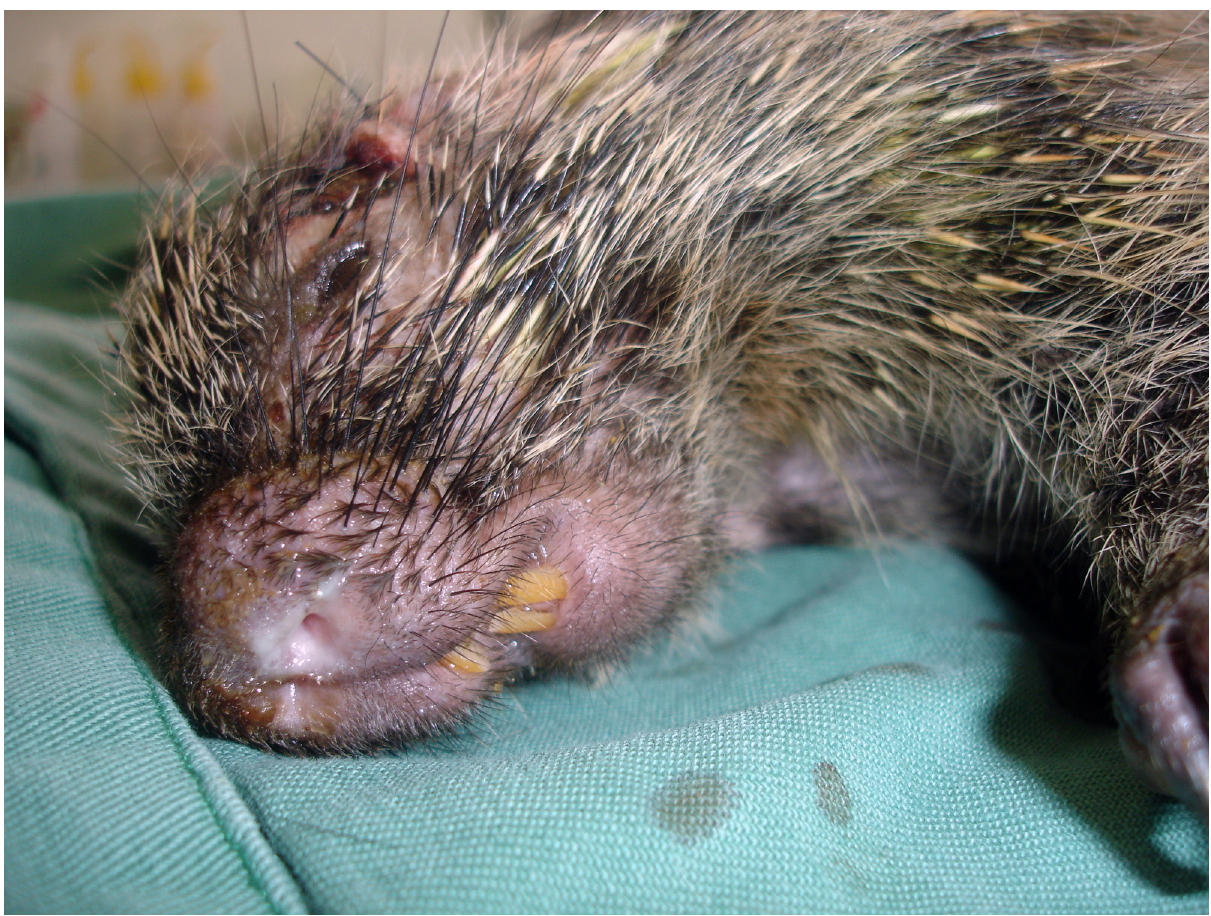
Figure 1. An orange-spined hairy dwarf porcupine ( Sphiggurus villosus ) had purulent discharge from the nasal cavity. Botucatu, SP,